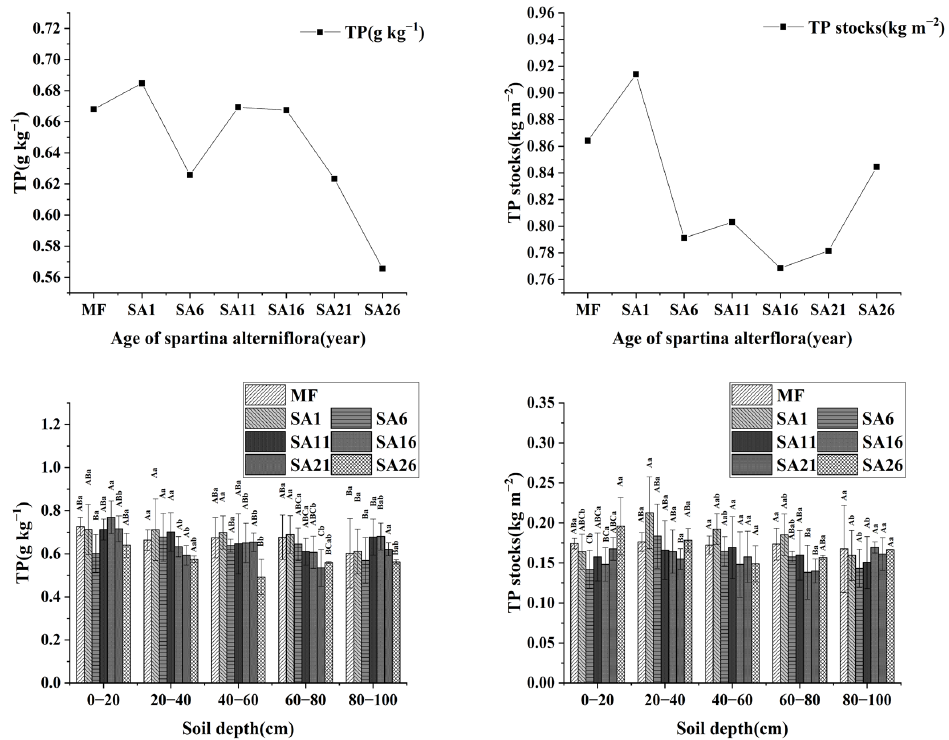
Figure 5. Distribution characteristics of soil TP content and storage at different stages of invasion. Different letters indicate significant differences between different years of invasion or soil depths. ( p < 0.05).